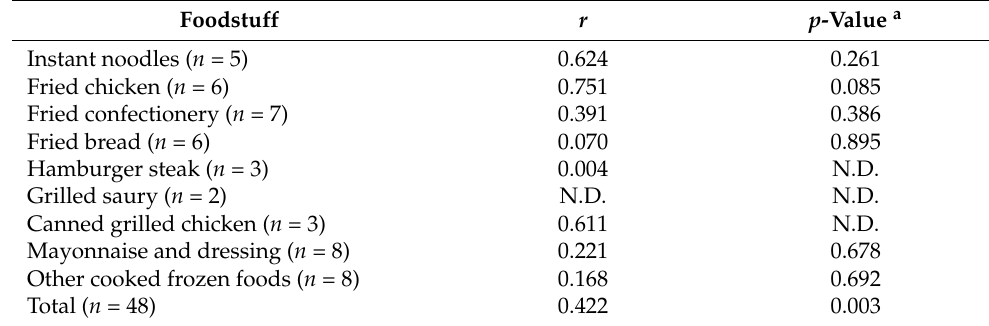
Table 5. Correlation between GEs and 3-MCPDEs in prepared foods using Pearson’s correlation coefficient.